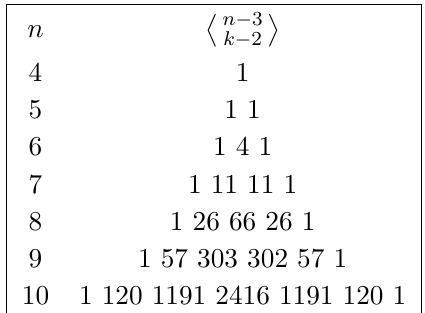
Table 1 . Eulerian numbers of solutions to the 4D scattering